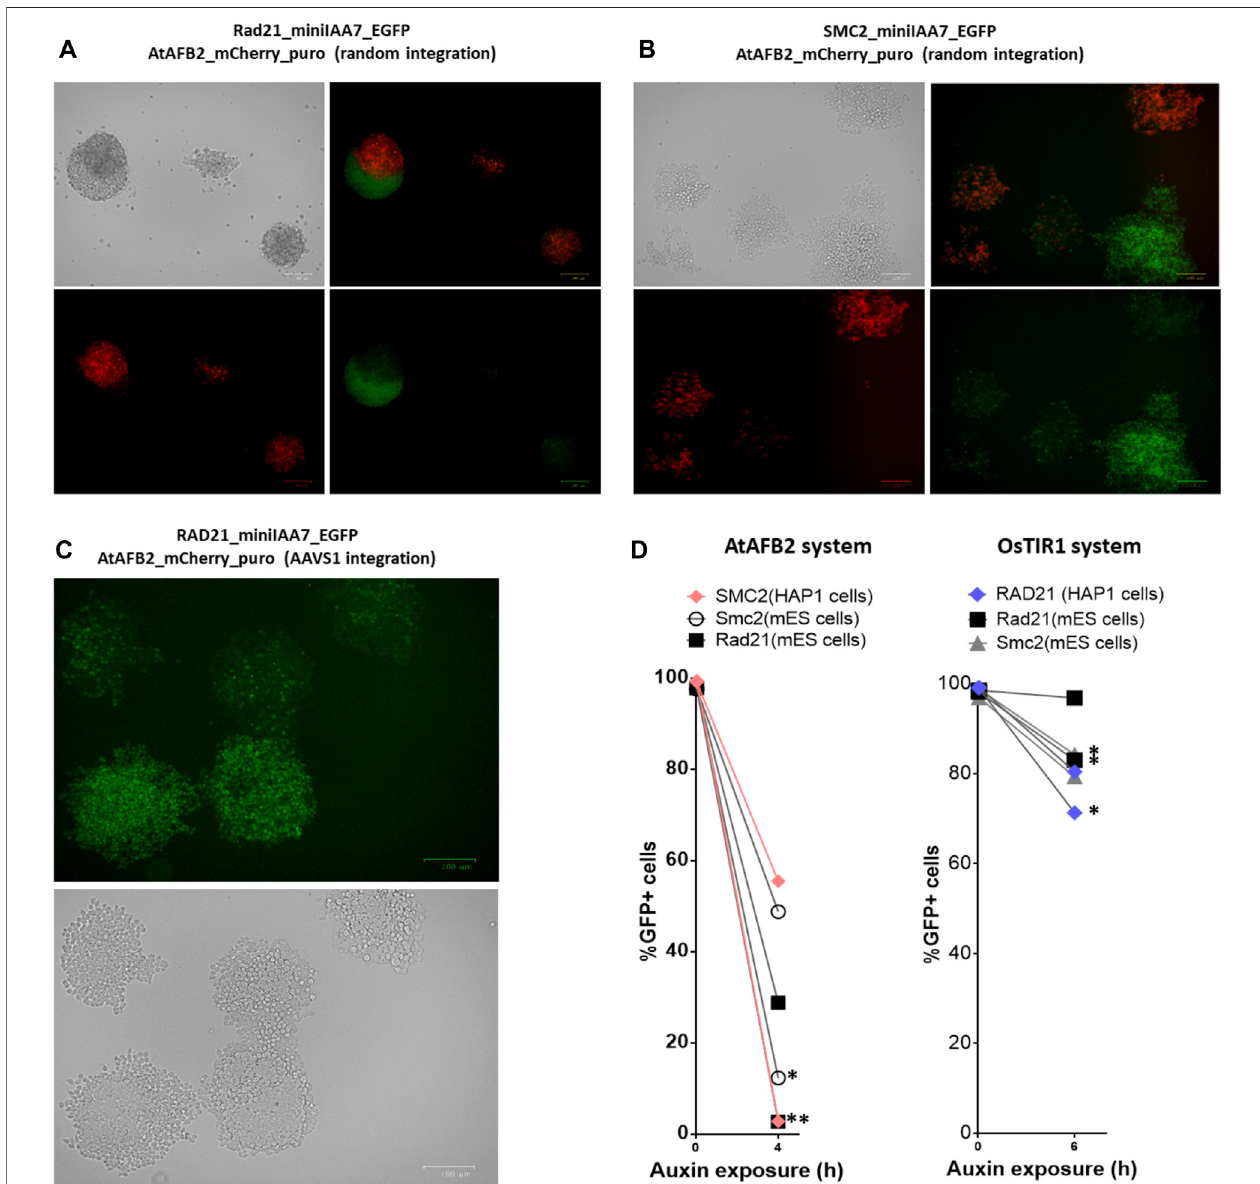
FIGURE 5 | Mosaic expression of AFBs in mESCs and HAP1 cells. One-cell derived colonies of mES cells (A) and HAP1 cells (B) bearing the AtAFB2 expression cassetteatrandomgenomiclociafterovernightauxinexposure. (C) One-cellderivedcoloniesofHAP1cellswithAtAFB2cassette integration intotheAAVS1locusafter overnight auxin exposure. (D) The addition of puromycin to the culture medium (*) restores the protein degradation ef fi ciency in mosaic clones. For each clone, the experiment was carried out once.